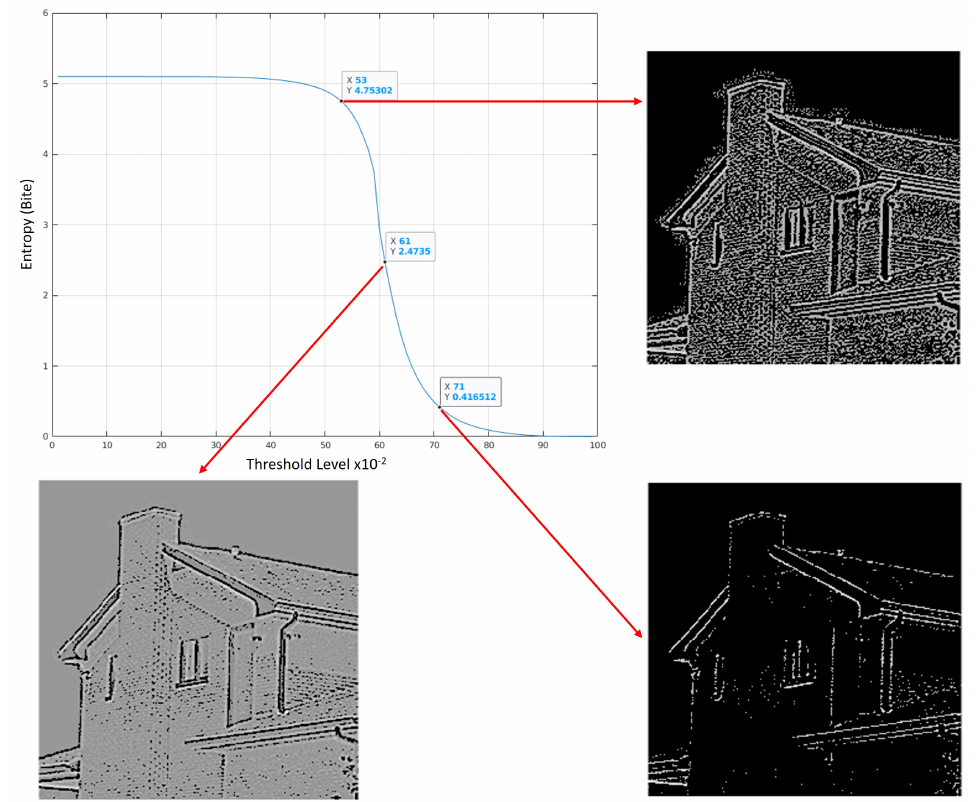
Figure 7. Shannon entropy curve for threshold selection and Coiflet wavelet. Output images are 258 × 258 pixels in size.